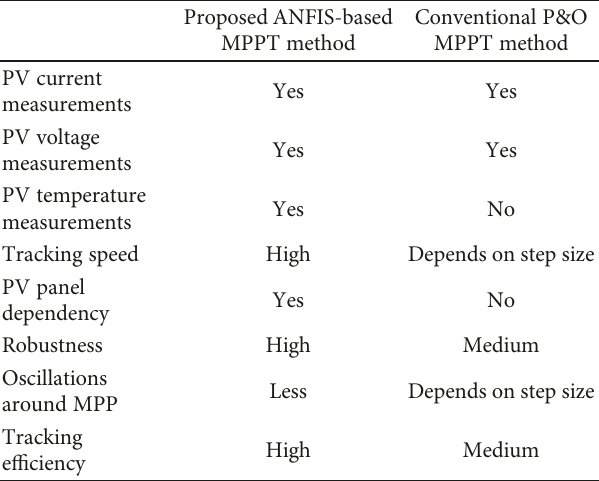
Table 3: Comparison of proposed MPPT and P&O MPPT